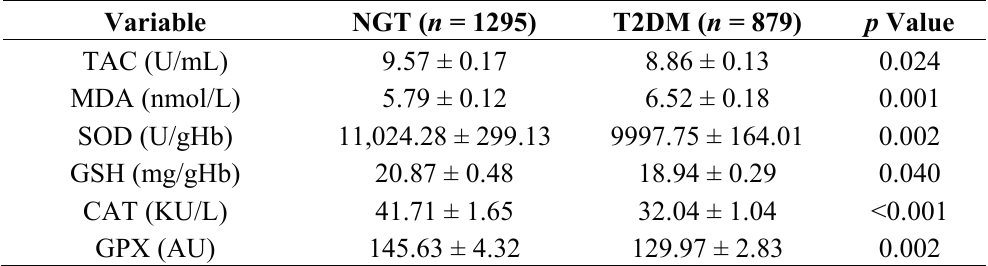
Table 4. Oxidative stress and anti-oxidative status in